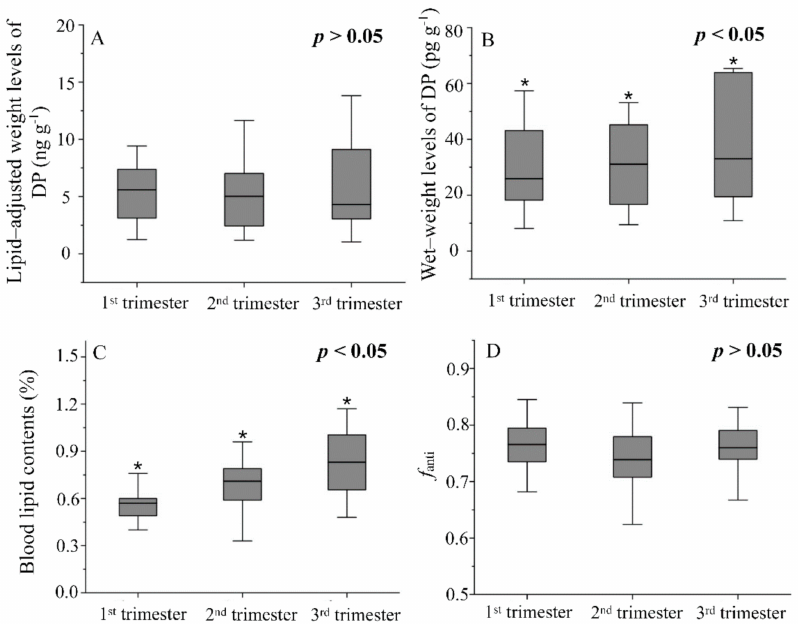
Figure 1. Box plot (minimum, 25% quartile, median, 75% quartile, and maximum; outliers were not shown) of lipid-adjusted levels of DP ( A ), wet-weight levels of DP ( B ), blood lipid contents ( C ), and f anti ( D ) of samples during three trimesters. (* trimester-related levels showed significant differences at p < 0.05. The sample sizes for the first, second, and third trimesters were 26, 25, and 24,